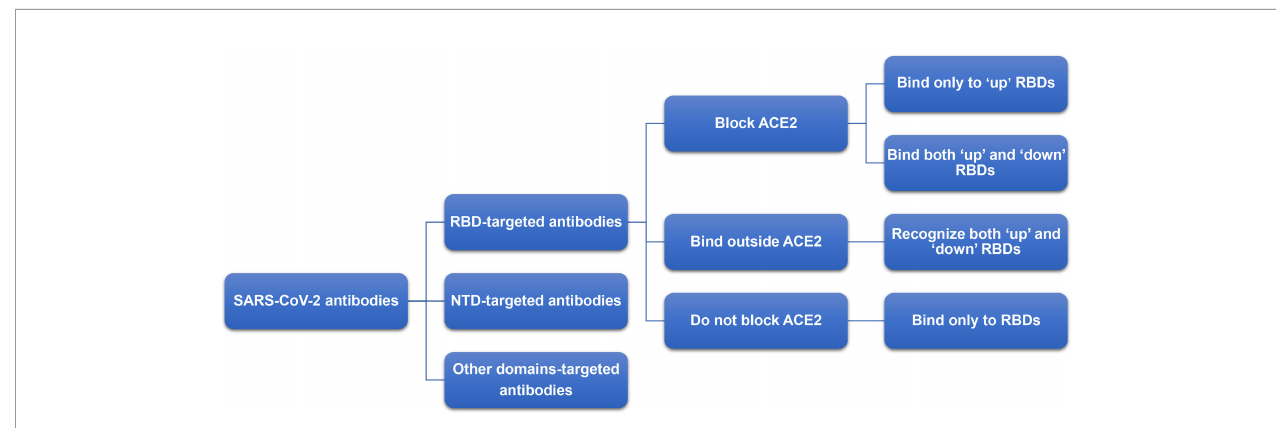
FIGURE 6 | Classi fi cation of neutralizing antibody targeting RBD. The neutralizing antibodies targeting SARS-CoV-2 RBD can be classi fi ed into four categories: (1) block ACE2 and bind only to ‘ up ’ RBDs; (2) block ACE2 and can bind to both ‘ up ’ and ‘ down ’ RBDs and can contact adjacent RBDs; (3) bind outside the ACE2 sites and recognize both ‘ up ’ and ‘ down ’ RBDs; (4) bind to the external residue sites of ACE2 and bind only to ‘ up ’